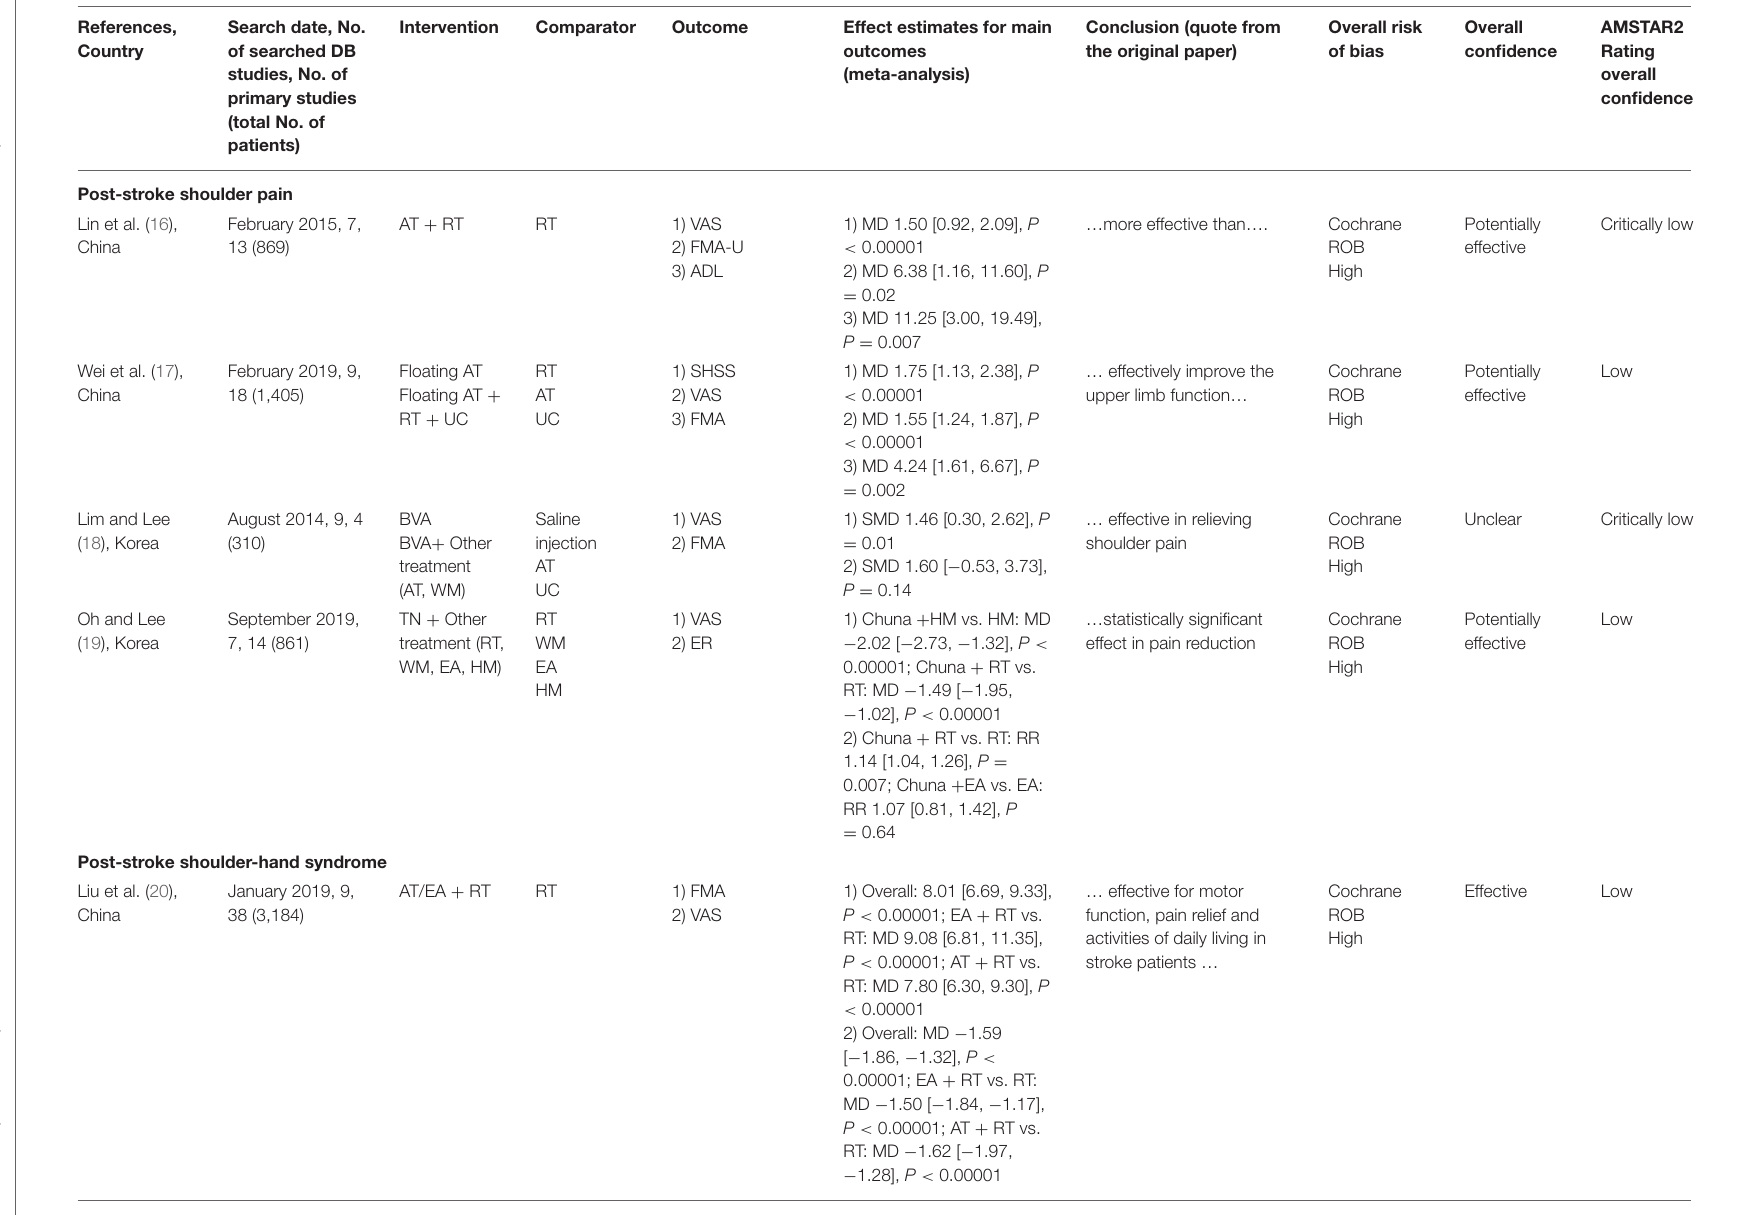
TABLE 2 | Summary of the included systematic reviews of post-stroke motor